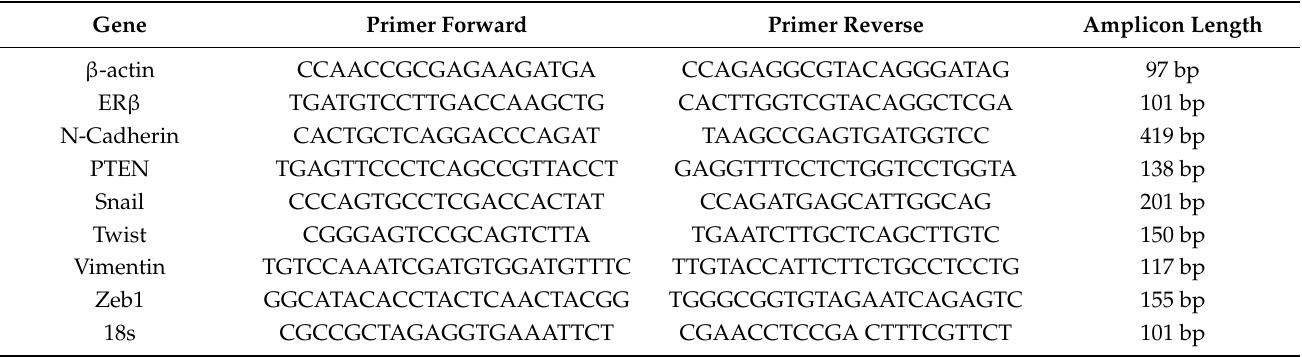
Table 1. Primer sequences for